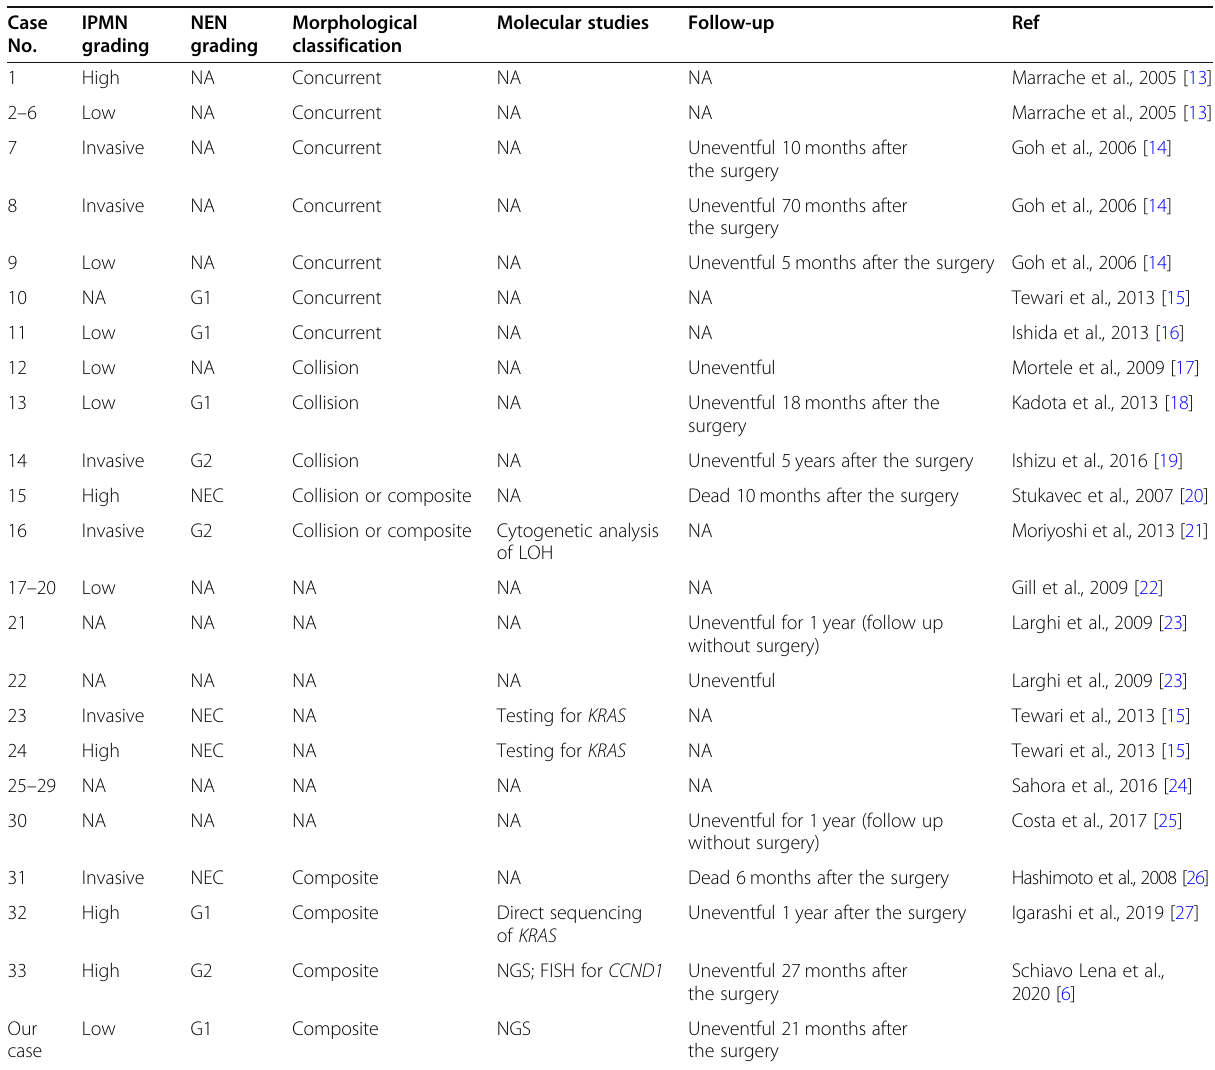
Table 3 Literature review of 33 cases of concomitant IPMN and NEN Case